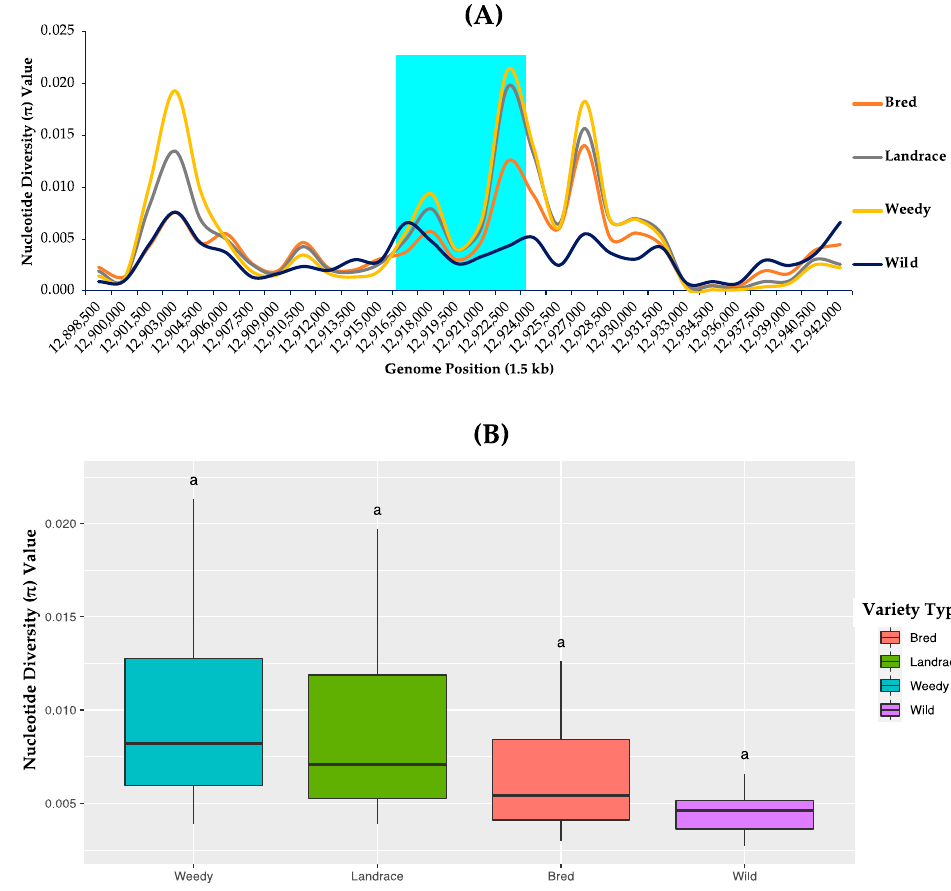
Figure 3. Nucleotide diversity analysis of GBSSII ( Os07g0412100 ) in the 475 Korean rice accessions utilizing the variety type (landrace, weedy, and bred) together with the wild group. ( A ) Nucleotide diversity ( π -value) representing the number of nucleotide variations within the GBSSII gene region at individual segregating sites in 1.5 kb sliding windows. Cyan indicates the GBSSII gene region, and each colored line represents a different rice varieties. ( B ) Box plots representing the different distribution patterns of GBSSII genetic variations based on mean nucleotide diversity values among the variety types. Lowercase letter “a” indicate a significant difference level at p -value <